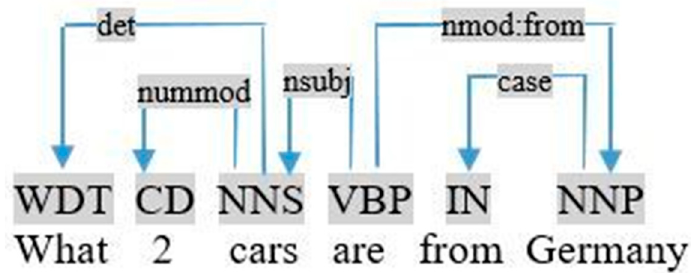
Figure 18. Graph dependency of the query «what 2 cars are from Germany».